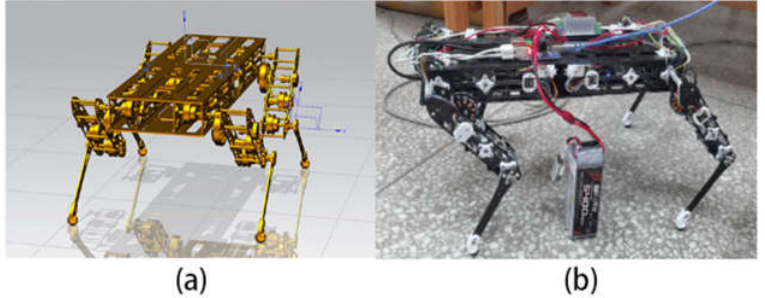
Figure 7. Quadruped robot for experiment. ( a ) Simulation of quadruped robot; ( b ) real robot of quadruped robot.